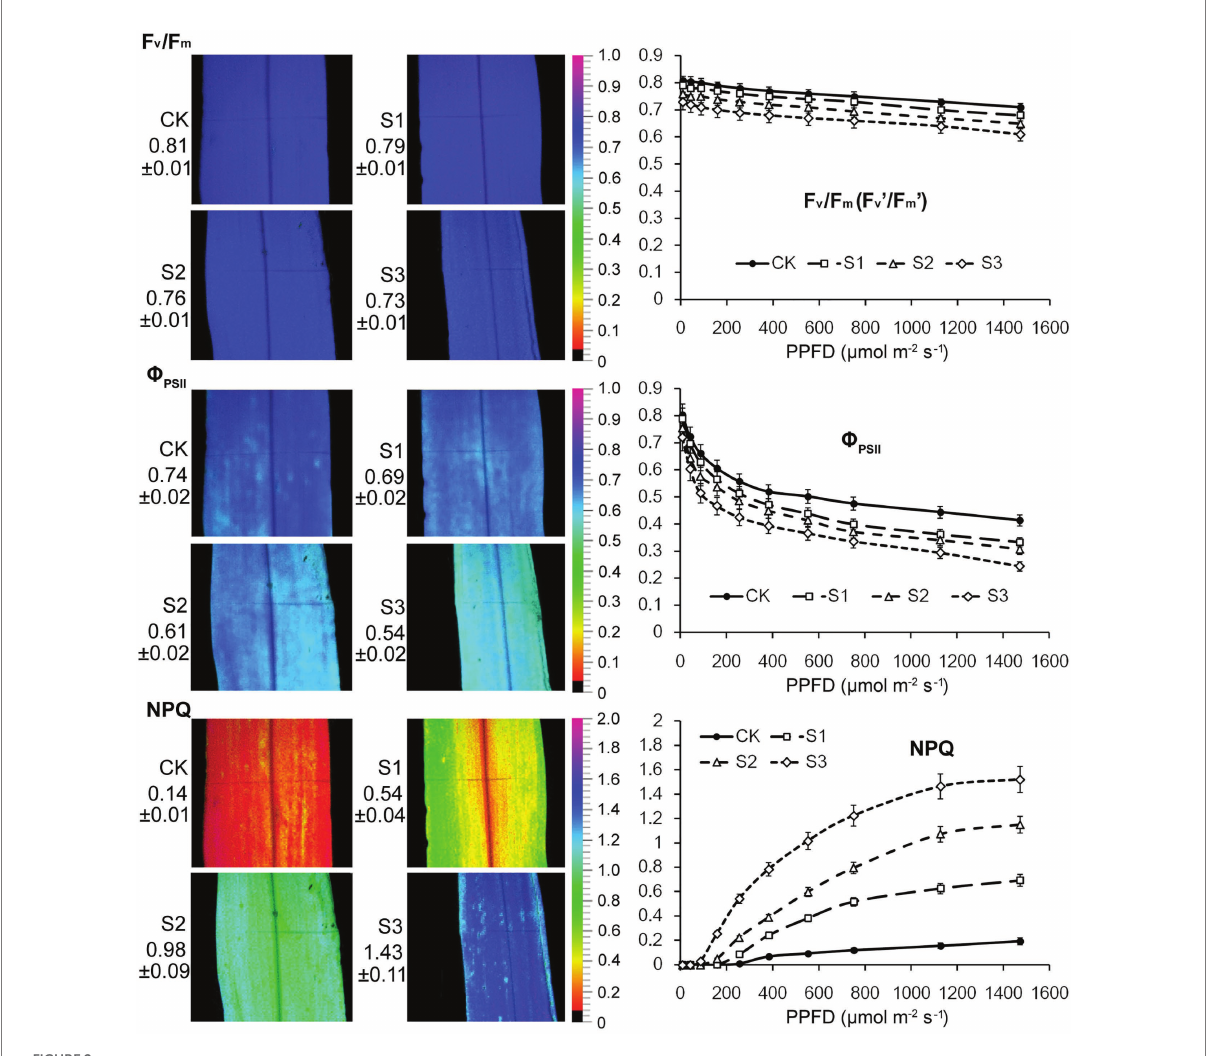
FIGURE 2 Chlorophyll fluorescence imaging and light response curves (LRCs) in intact maize leaves under drought stress. Fv/Fm, the maximal photochemical quantum yield of PSII in darkness; Fv’/Fm’, the maximal photochemical quantum yield of PSII under light; Φ PSII , the effective photochemical quantum yield of PSII under light; NPQ, the non-photochemical fluorescence quenching under light. CK, well-watered control; S1, mild drought stress; S2, moderate drought stress; and S3, severe drought stress. Values beside the individual images present quantitative means ± SD ( n = 4). Vertical bars represent SD of the mean ( n =